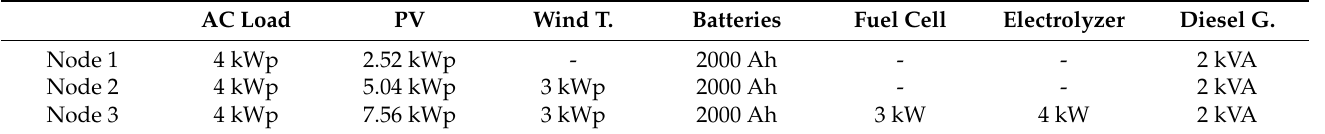
Table 1. Power characteristics of the integrated